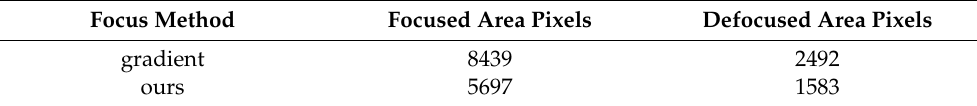
Table 1. The number of pixels in some foreground images of different focus calculation methods. Focus Method Focused Area Pixels Defocused Area Pixels gradient 8439 2492 ours 5697 1583